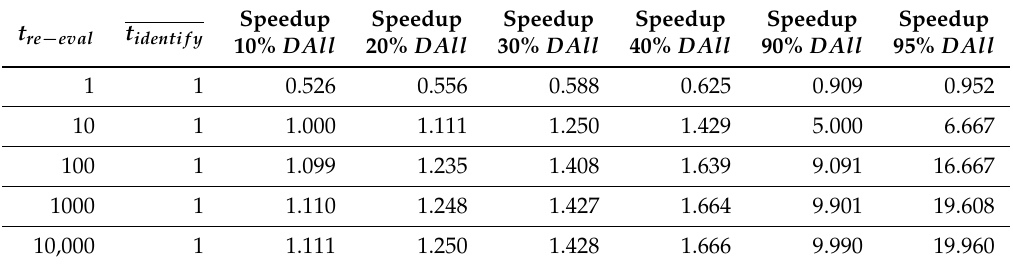
Table 3. Relations between time, percentage of duplicates, and